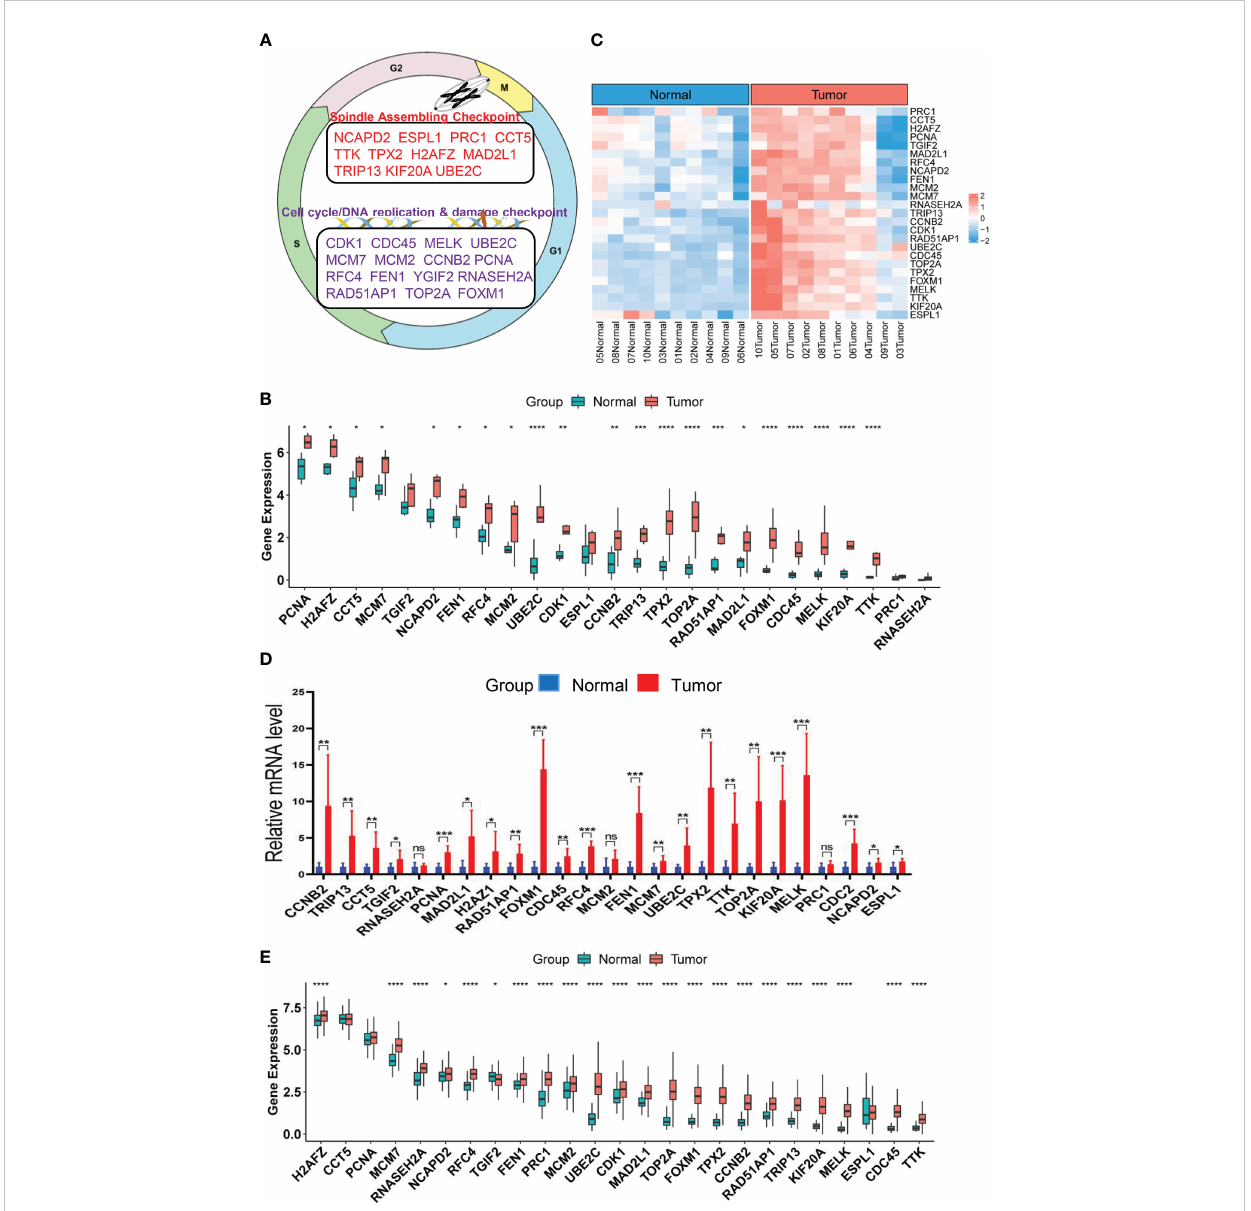
FIGURE 1 Upregulation of CIN25 genes in ccRCC tumors. (A) The CIN25 signature genes and their function. (B) Upregulated expression of 25 genes included in the CIN25 signature in primary ccRCC tumors. Tumors and matched non-tumorous tissues (NTs) from 10 patients were analyzed for transcriptomic pro fi le and expression levels of CIN25 genes were expressed as Transcripts Per Million (TPM) counts. (C) The heatmap showing CIN25 ssGSEA scores between 10 ccRCC tumors and their matched NTs. (D) The qPCR validation of upregulated CIN25 gene expression in primary ccRCC tumors. Paired specimens from 9 ccRCC patients were analyzed for mRNA levels of CIN25 genes. mRNA levels of target genes were based on 2 ( − DD CT) values and normalized by b -actin expression. (E) Differences in expression of 25 CIN25 signature genes between 530 ccRCC tumors and 72 NTs in the TCGA cohort. TPM was used for expression level. *, **, *** and **** indicate P values <0.05, 0.01, 0.001 and 0.0001, respectively. ns, Not signi fi